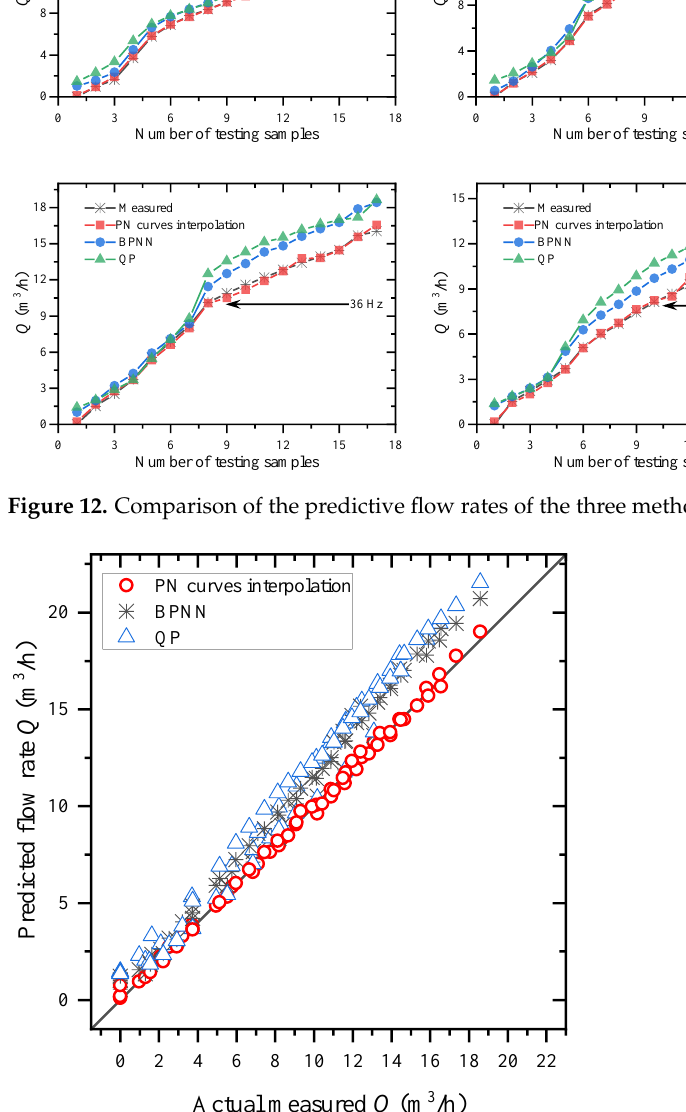
Figure 13. Comparison of the results of the three estimation methods. Figure 14 presents the absolute and relative errors of the three methods, and the specific data are shown in Table 3. The mean absolute error of the interpolation method is 0.1756 m 3 /h, which is much lower than the other two prediction methods. Meanwhile, the mean relative error of the interpolation method is 2.6919%, while the mean relative error of BPNN and QP prediction methods is 16.6261% and 23.3509%, both of which are much higher than the relative error of the interpolation method. This indicates that the PN curve interpolation prediction method is more accurate and stable.